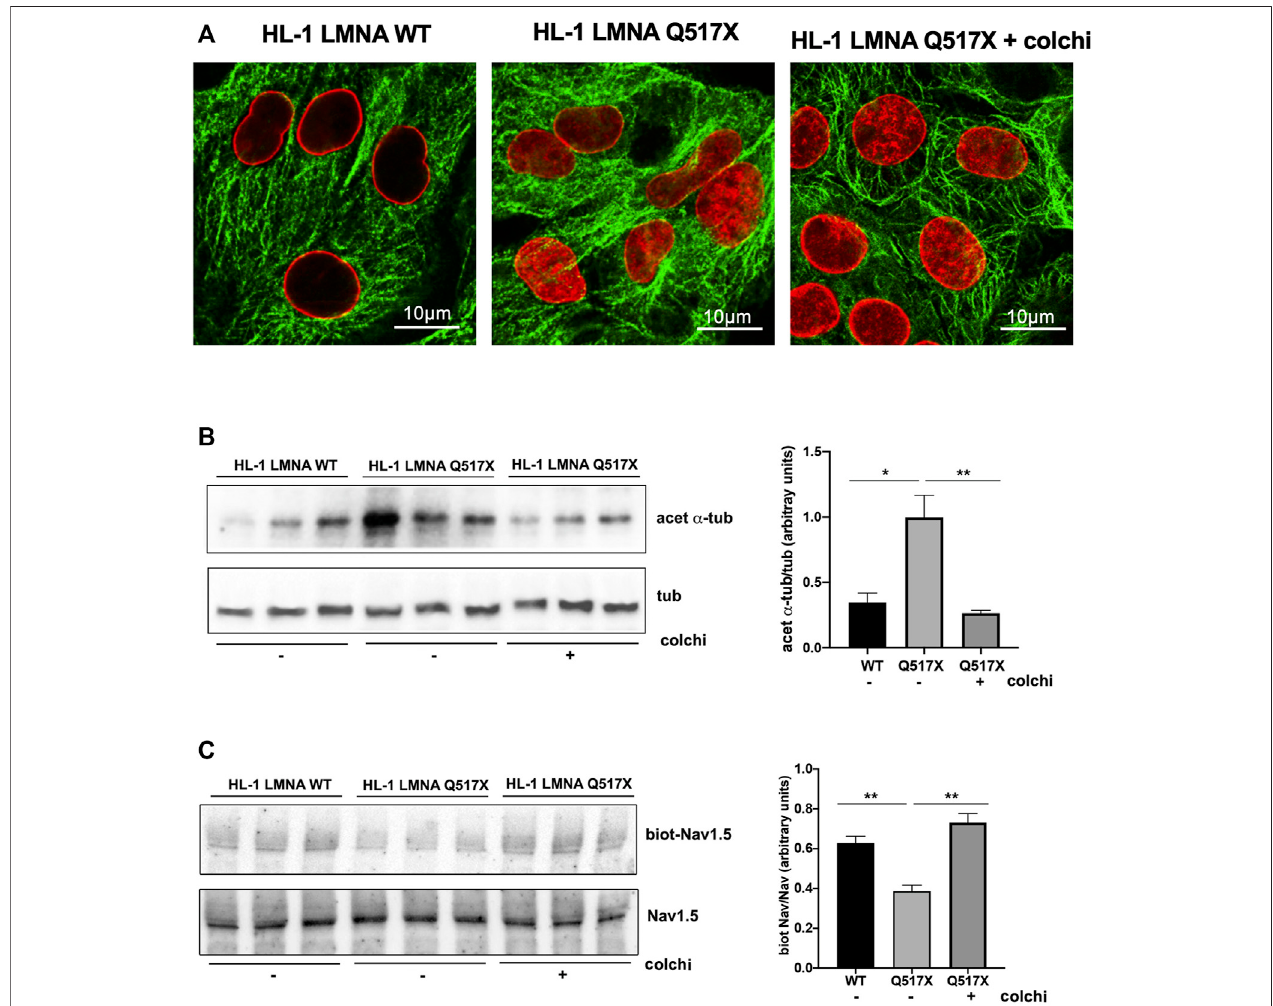
FIGURE 6 | (A) Representative immuno fl uorescence confocal images of HL-1 cells expressing either LMNA WT or LMNA Q517X, the latter treated or not with colchicine (+colchi). (B) Left panel: representative western blot of acetylated α tubulin (acet α -tub) and total α tubulin (tub) in the absence ( – ) or the presence (+) of colchicine(colchi)inLMNAWT andLMNAQ517X-expressing HL-1cells;rightpanel: normalized densitometric analysisofacetylated α -tubulin immunoreactive bandsin alltheexperimentalconditionsshownintheleftpanel. (C) Leftpanel:representativewesternblotofcellssurfacebiotinylatedNav1.5(biot-Nav1.5)andNav1.5incell lysates (Nav1.5) in the absence ( – ) or presence (+) of colchicine (colchi) in LMNA WT and LMNA Q517X-expressing HL-1 cells; right panel: normalized densitometric analysis of biot-Nav1.5 immunoreactive bands in all the experimental conditions shown in the left panel. The data are means of 3 independent experiments * p < 0.01, ** p < 0.001, one-way